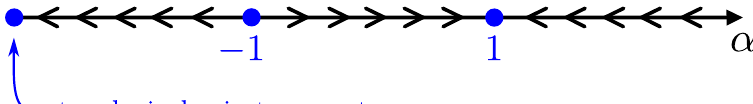
Figure 15 . The coefficient of the scalar bi-linear α in (2.3) undergoes an RG flow on the line. The fixed point at α = 1 is stable while the fixed point at α = − 1 is unstable. Starting from the unstable fixed point, two flows exist. One moves in the direction of the stable fixed point, while the other moves in the other direction toward a topological spin transport that is essentially trivial